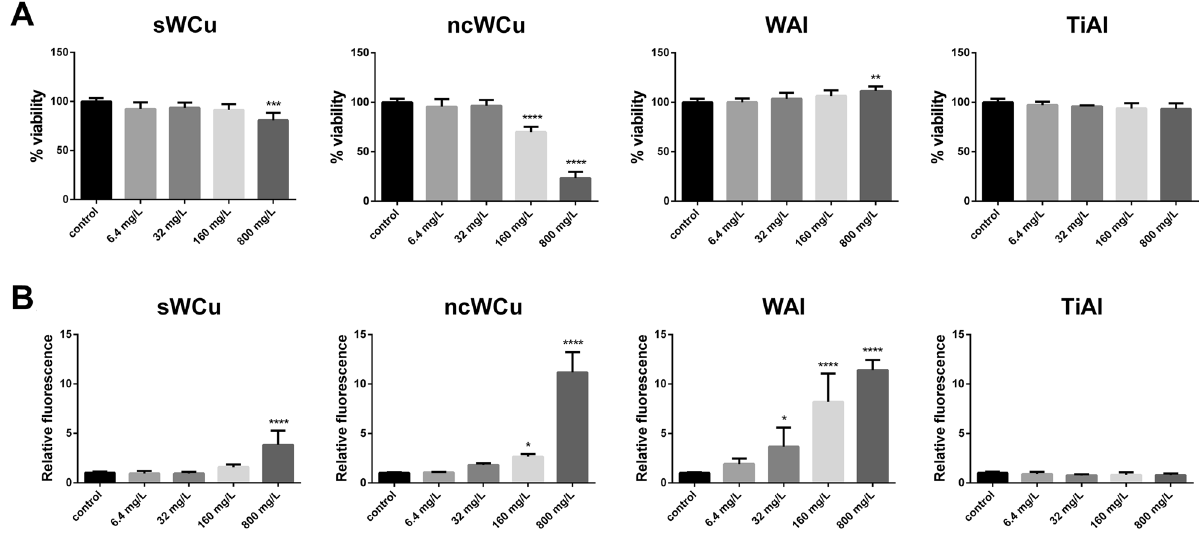
Figure 2. Impact of direct exposition of A549 cells to different concentrations of the metal powders. ( A ) Viability of A549 cells (Neutral Red assay). Results are expressed as % of control (untreated cells). ( B ) Oxidative stress (ROS levels) in A549 cells. Results are expressed as the relative fluorescence value to the control (untreated cells) which was assigned a value of 1. Data represent the mean ± standard deviation, SD. Differences were established using a One-way ANOVA followed by Dunnett post hoc test to compare every mean with the control, and considered significant at P ≤ 0.05. * P ≤ 0.05, ** P ≤ 0.01, *** P ≤ 0.001, **** P ≤ 0.0001.